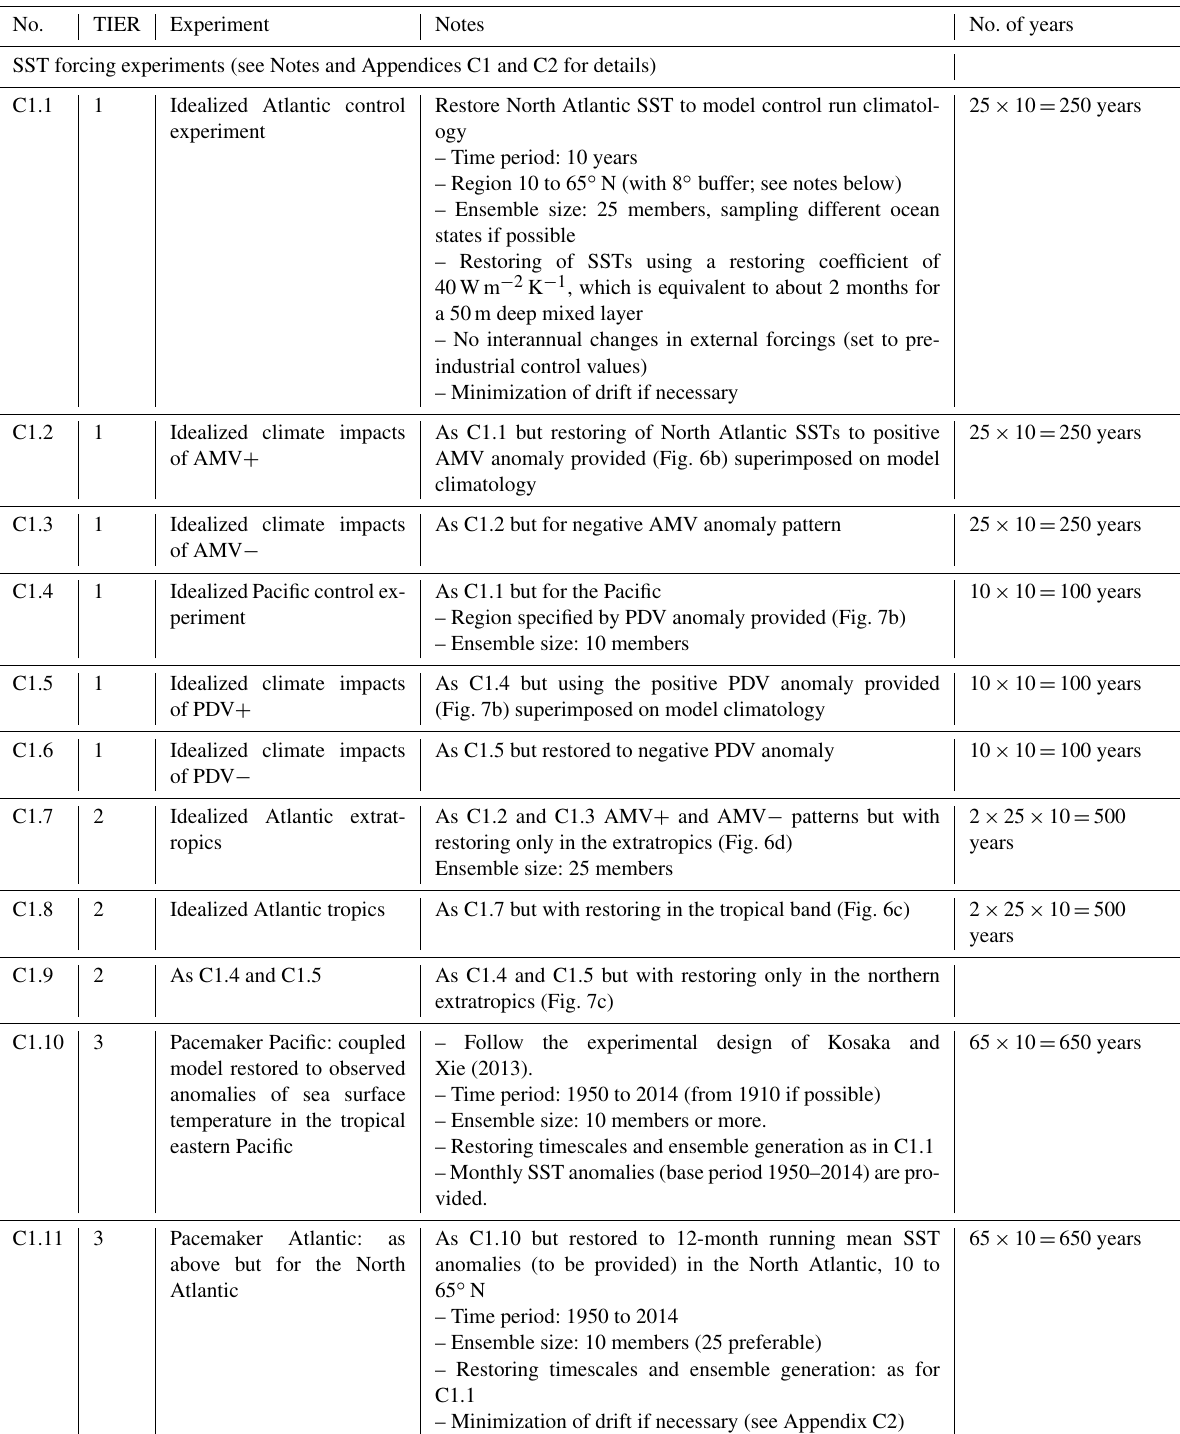
Table C1. Accelerated and retarded rates of global temperature change and the associated regional climate variations. No. TIER Experiment Notes No. of years SST forcing experiments (see Notes and Appendices C1 and C2 for details)